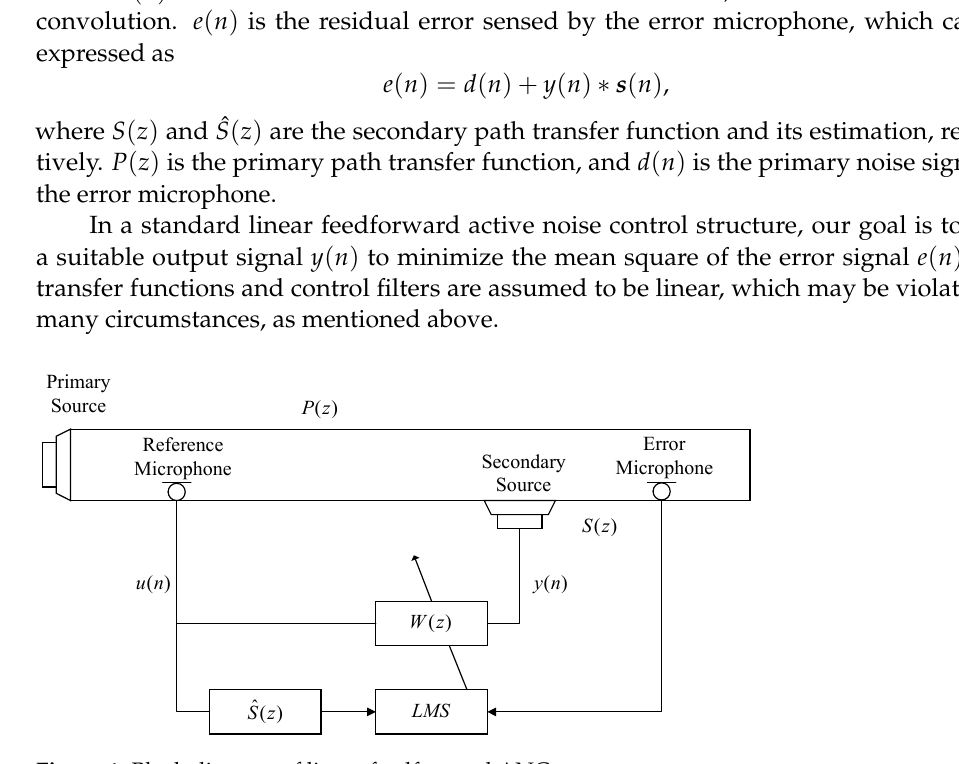
Figure 1. Block diagram of linear feedforward ANC